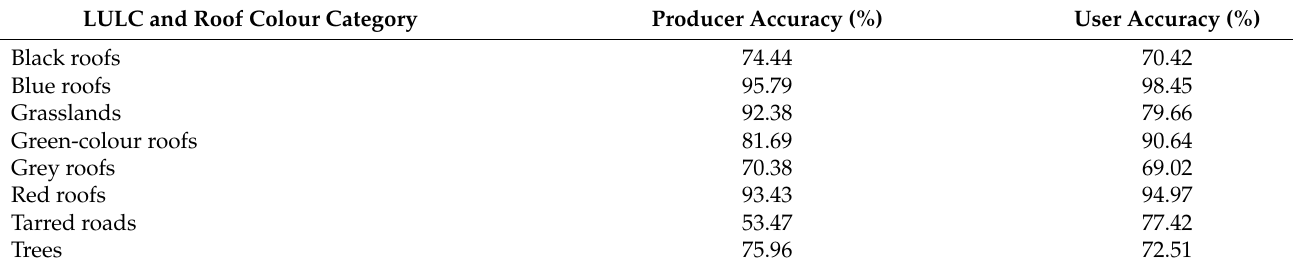
Table 2. LULC and roof colour mapping